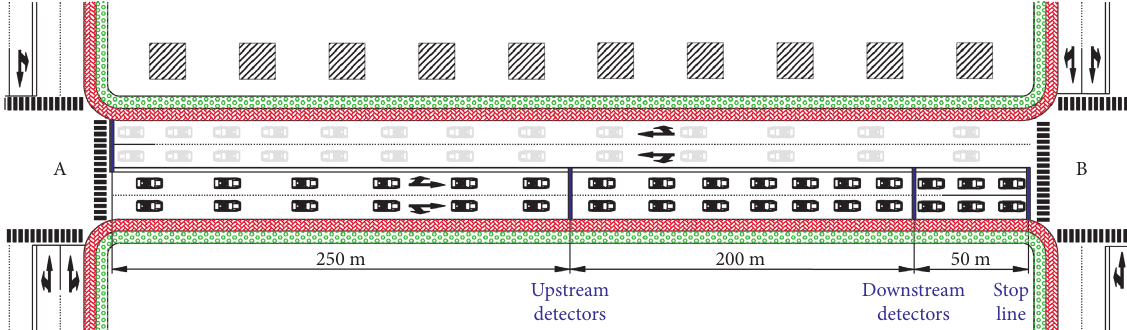
Figure 4: Simulation model and detector settings.